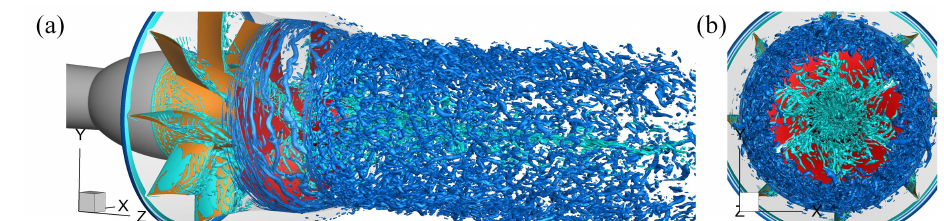
Figure 23. ( a ) vortices identified by the Ω method in the flow field of PJP model S8R6 at J = 0.6; ( b ) back